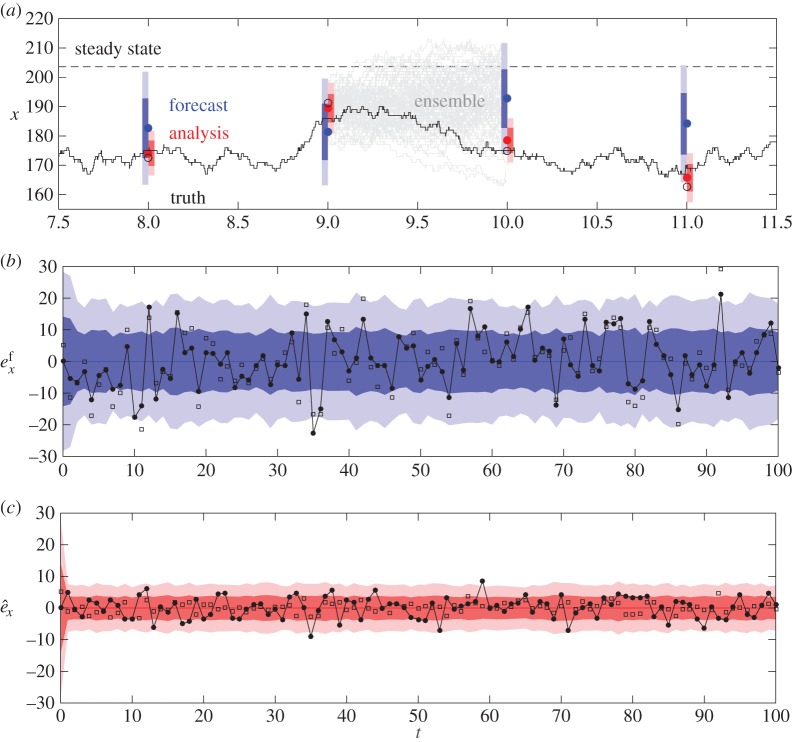
Illustration of the EnKF applied to the box model. (a) Synthetic ground truth data are represented by the solid black line, noisy observations are indicated by open circular black markers, the forecasts by blue markers and the analysis by red markers. Individual ensemble realizations are plotted in grey. (b) and (c) illustrate the forecast and analysis errors, respectively. More details are included in the main text.